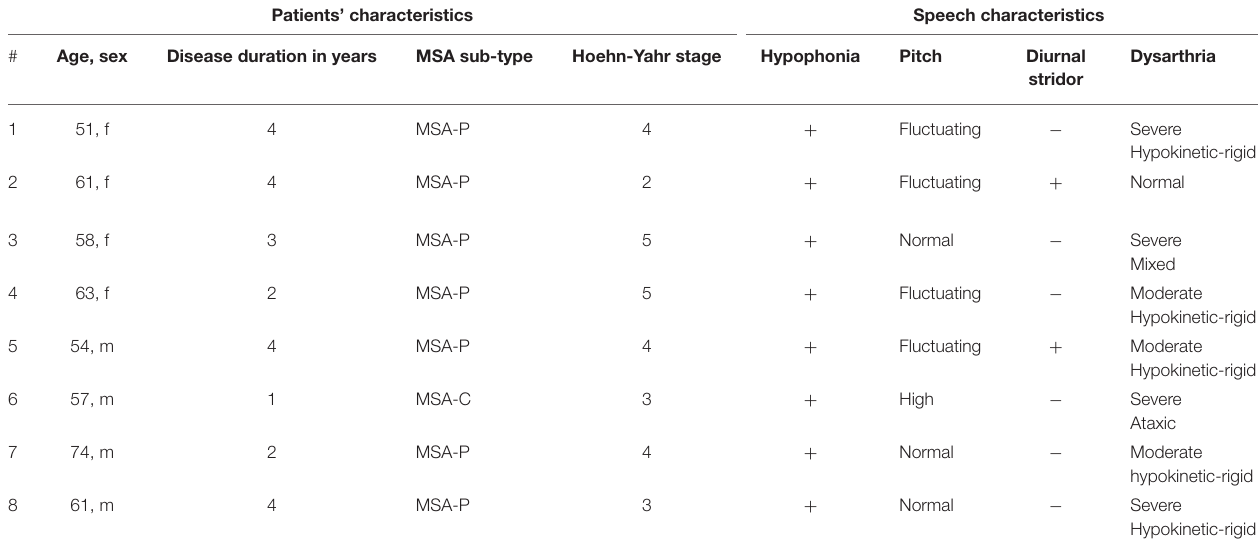
TABLE 5 | Patients’ demographic data and speech characteristics.